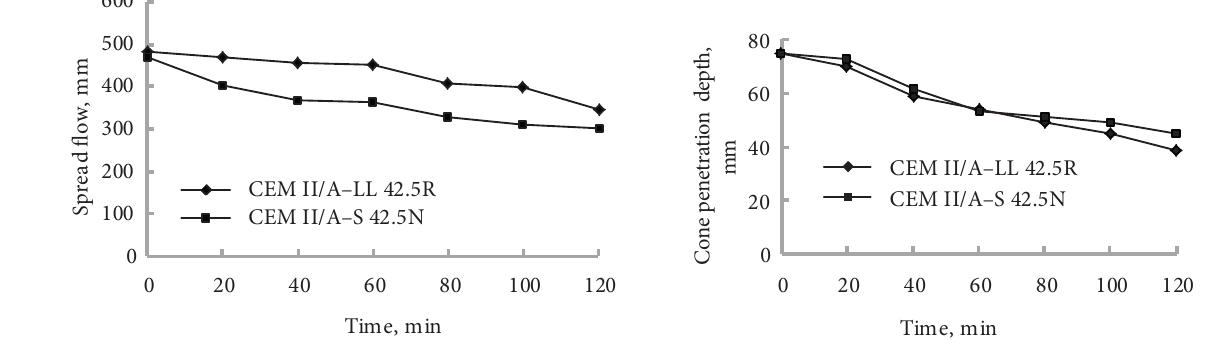
Fig. 5. A concrete mixture with different types of Portland cement and dependence of the superplasticizer having the spread flow of 1.25% on time at a temperature of +15 °C